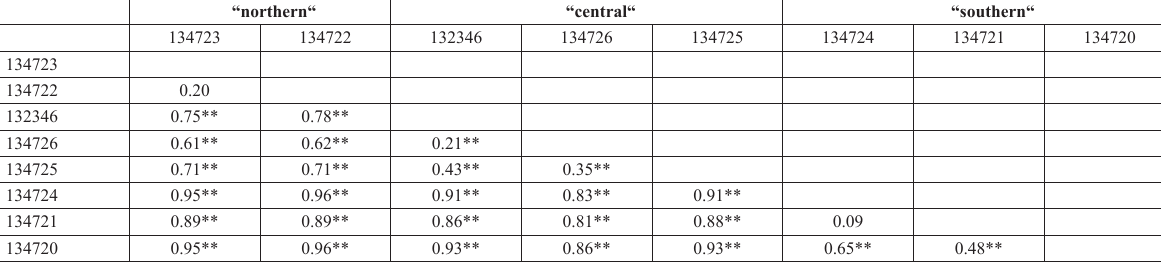
Table 5. Pairwise genetic differentiation. Genetic differentiation was measured with pairwise φ sequenced individuals are shown. P-values Bonferroni corrected to account for multiple comparisons. “northern“ “central“